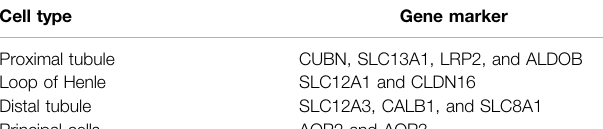
TABLE 1 | Gene markers used for the annotation of cell